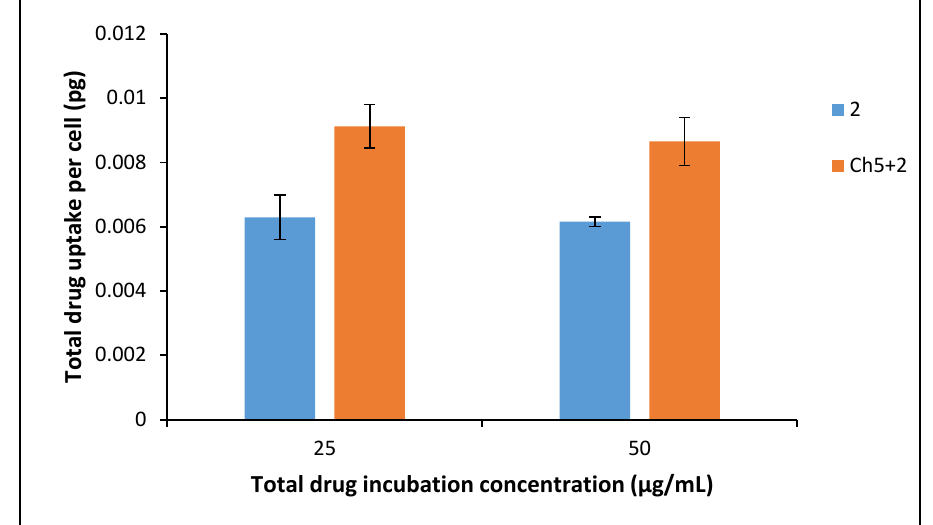
Figure 7. Drug uptake into BxPC-3 cells after 4 h exposure of 25 µg/mL and 50 µg/mL drug and formulation ( n = 3, ±SD).